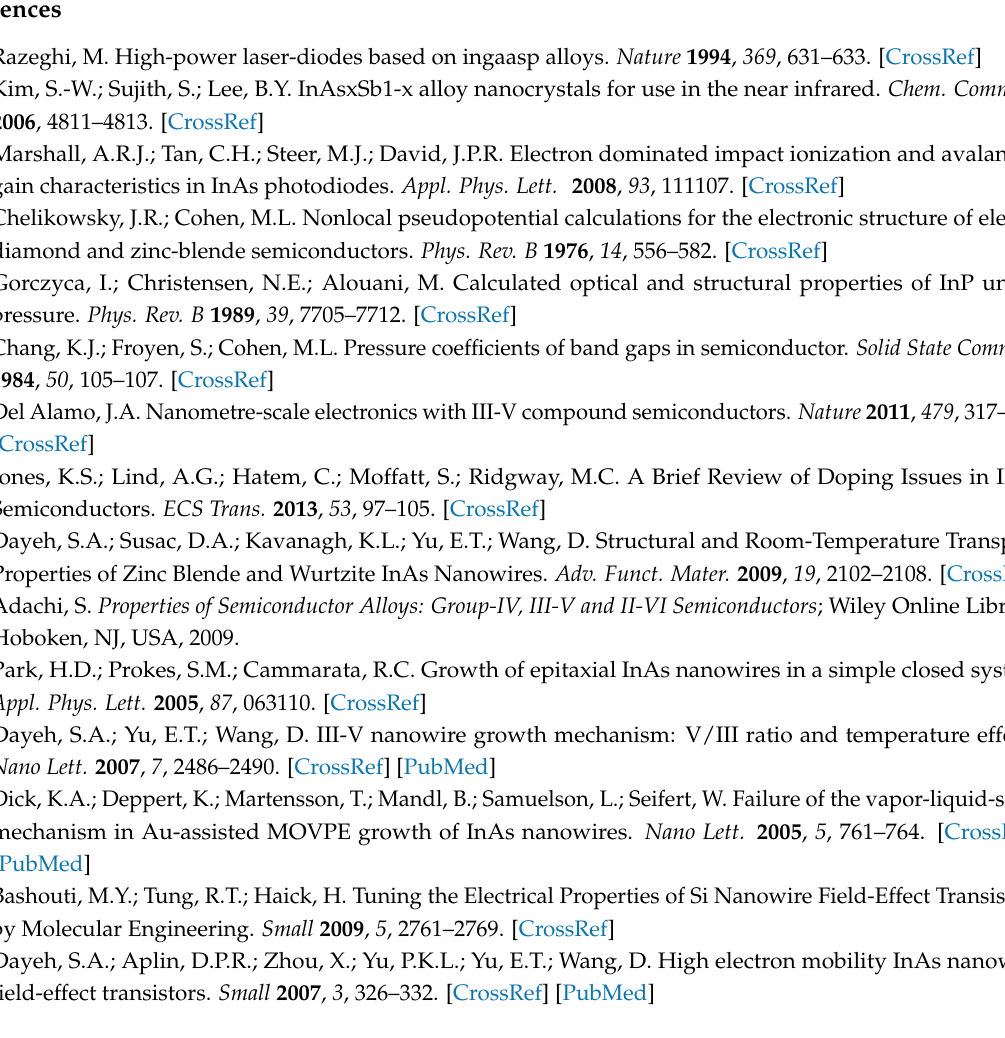
Figure S1: Defect formation energy in As-rich environment, Figure S2: Defect formation energy in In-rich